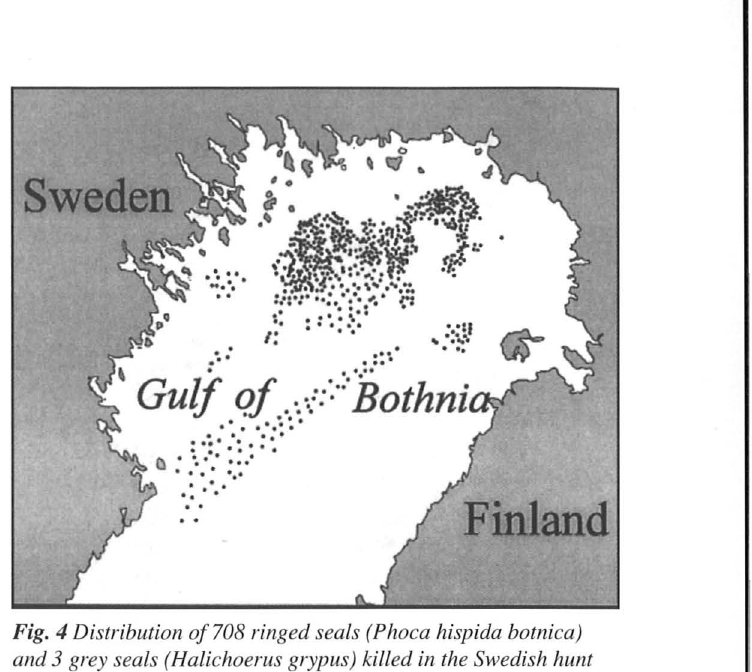
Fig. 4 Distribution of 708 ringed seals (Phoca hispida botnica) and 3 grey seals (Halichoerus grypus) killed in the Swedish hunt in the Gulf of Bothnia 12 March - 20 May 1930. Re-drawnfrom O/afsson